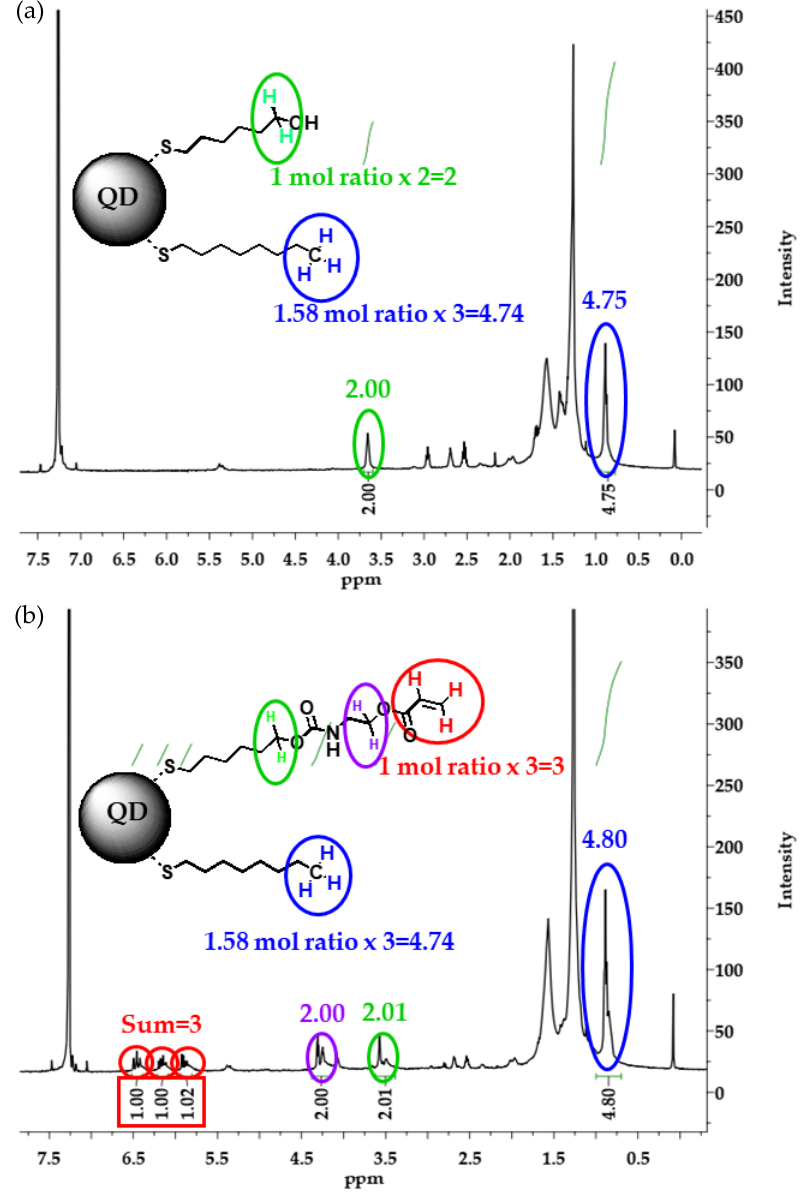
Figure 2. 1 H-NMR spectra of ( a ) the ligand-exchanged hydroxyl-terminated quantum dots (QD-OH) and ( b ) the acrylate-terminated quantum dots (QD-Acrylate).